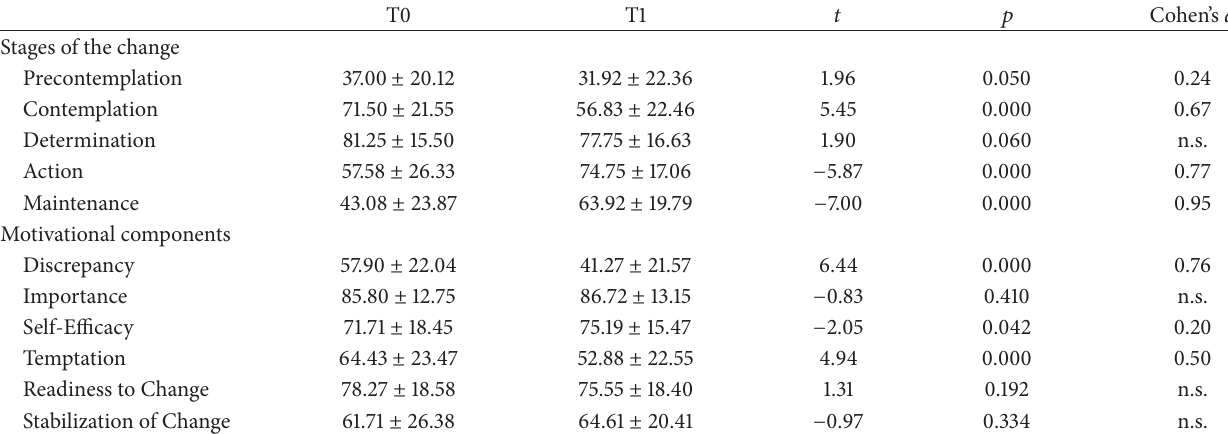
Table 3: Motivation to change to health nutrition (NUTR). Data are presented as mean ± SD.